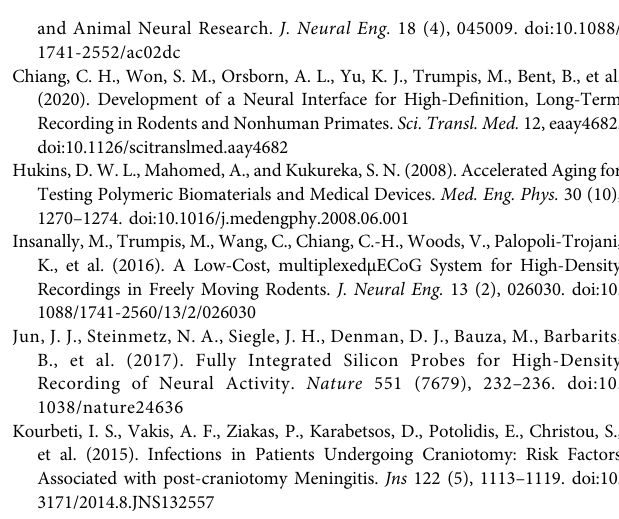
Supplementary Figure S1 | Correlation for MUX channels at different impedances. (i) Grounded inputs. Left: Correlation coef fi cients matrix. Right: Average correlation rank for each channel (11 output columns, 6 channel rows per output). (ii) Z = 3.4 k Ω (Pt-Ir coated contacts, LCP electrode array). Left: Correlation coef fi cients matrix. Right: Average correlation rank for each channel (11 output columns, 6 channel rows per output). (iii) Z = 27.0 k Ω (Pt-Ir foil, silicone electrode array). Left: Correlation coef fi cients matrix. Right: Average correlation rank for each channel (11 output columns, 6 channel rows per output). (iv) Z = 38.5 k Ω (Au contacts, LCP electrode array). Left: Correlation coef fi cients matrix. Right: Average correlation rank for each channel (11